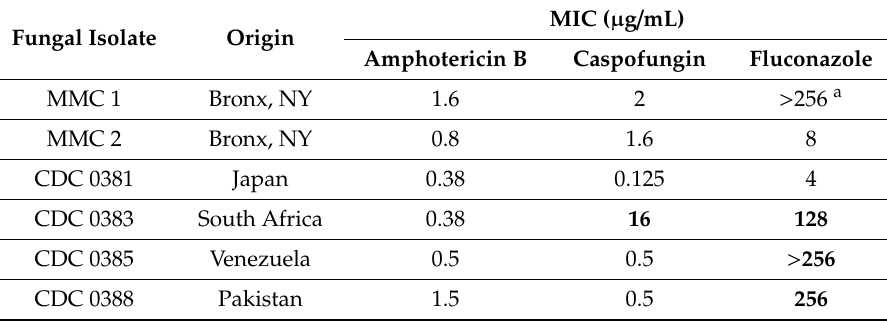
Table 1. C. auris strains were collected from Montefiore Medical Center (MMC) and the Centers for Disease Control (CDC). Tentative MIC breakpoints (bolded values) for C. auris are reported from the CDC as: amphotericin B ≥ 2; caspofungin ≥ 2; fluconazole ≥